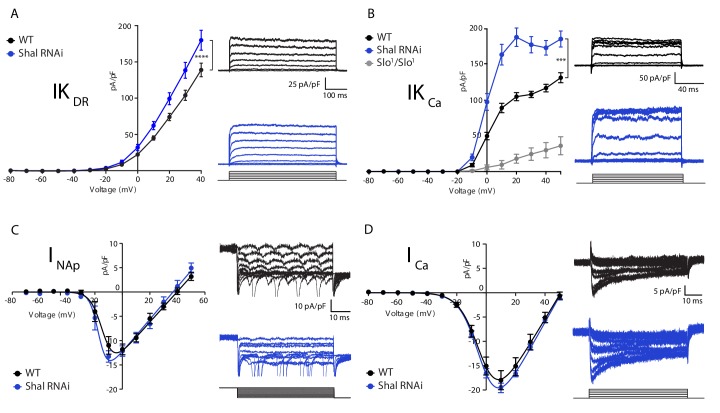
Homeostatic potassium current rebalancing stabilizes MN1 excitability in the absence of Shal-dependent IKA.(A, B) I-V plots and representative traces of voltage-dependent delayed rectifier (IKDR, (A) and Ca2+-dependent (IKCa, (B) potassium currents in WT (black; n = 7 and n = 9 for IKDR and IKCa, respectively) and Shal-RNAi (blue; n = 12 and n = 8 for KDR and KCa, respectively) MN1. The specificity of the IKCa current protocol was confirmed in slo1 mutants (B, grey; n = 4), which exhibited minimal Ca2+-dependent potassium currents. (C, D) I-V plots and representative traces of persistent sodium currents (INaP, C, WT: n = 9; Shal-RNAi: n = 9) and voltage dependent calcium currents (ICa, D; WT, n = 8; Shal-RNAi, n = 6) in WT (black) and Shal-RNAi (blue) MN1. Mean ± S.E.M.; *p<0.05; **p<0.005; ***p<0.0005. N.S., not significant; two-way RM-ANOVA with Bonferoni post-hoc tests (I-V plots).